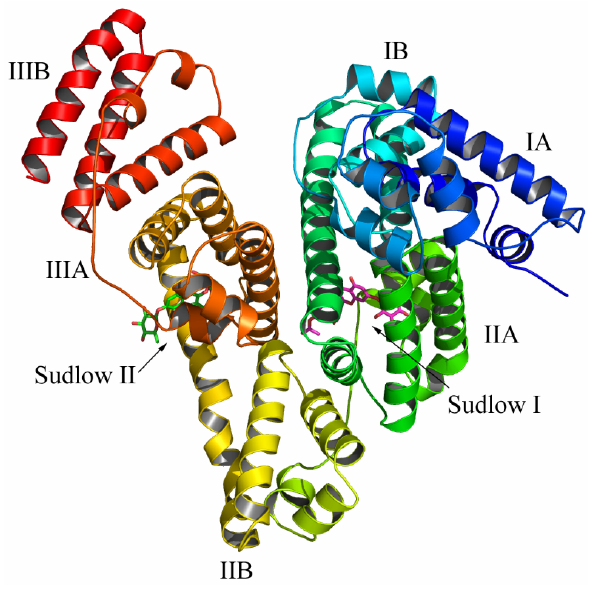
Figure 10. Compound 6 was docked into the Site I (IIA) and Site II (IIIA) binding pockets of the BSA.